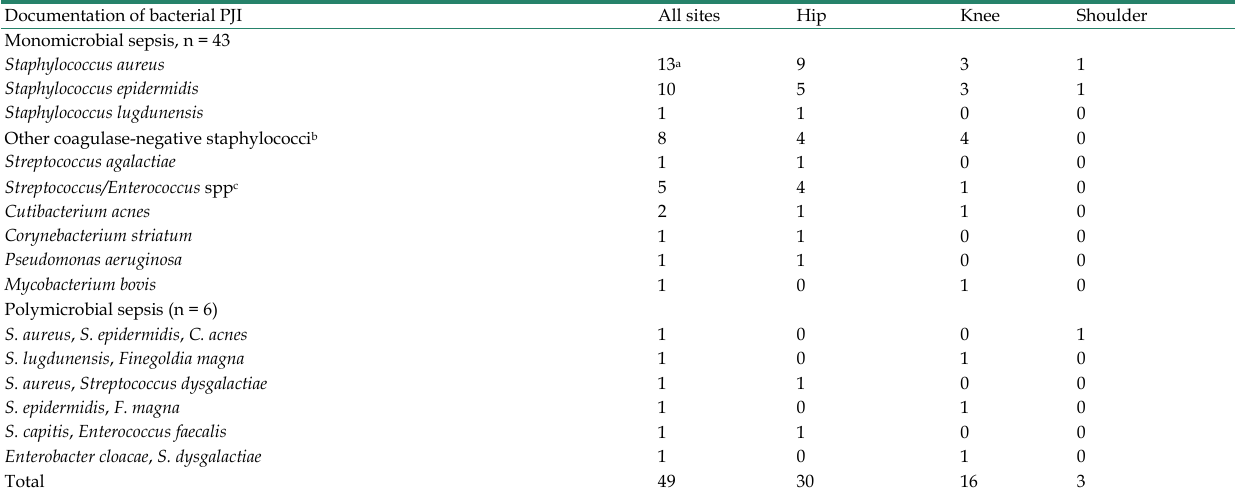
Table 2. Microbial species involved in the preoperative or perioperative samples Documentation of bacterial PJI All sites Hip Knee Shoulder Monomicrobial sepsis, n = 43 Staphylococcus aureus